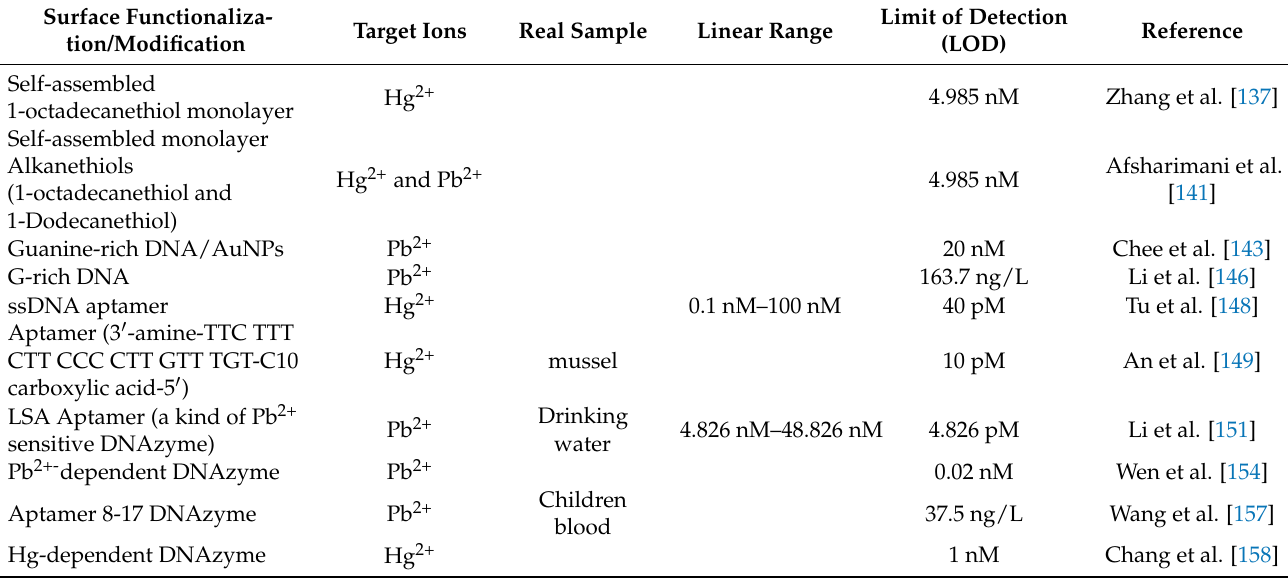
Table 4. Recent heavy metal ions sensing strategies on the Graphene FET